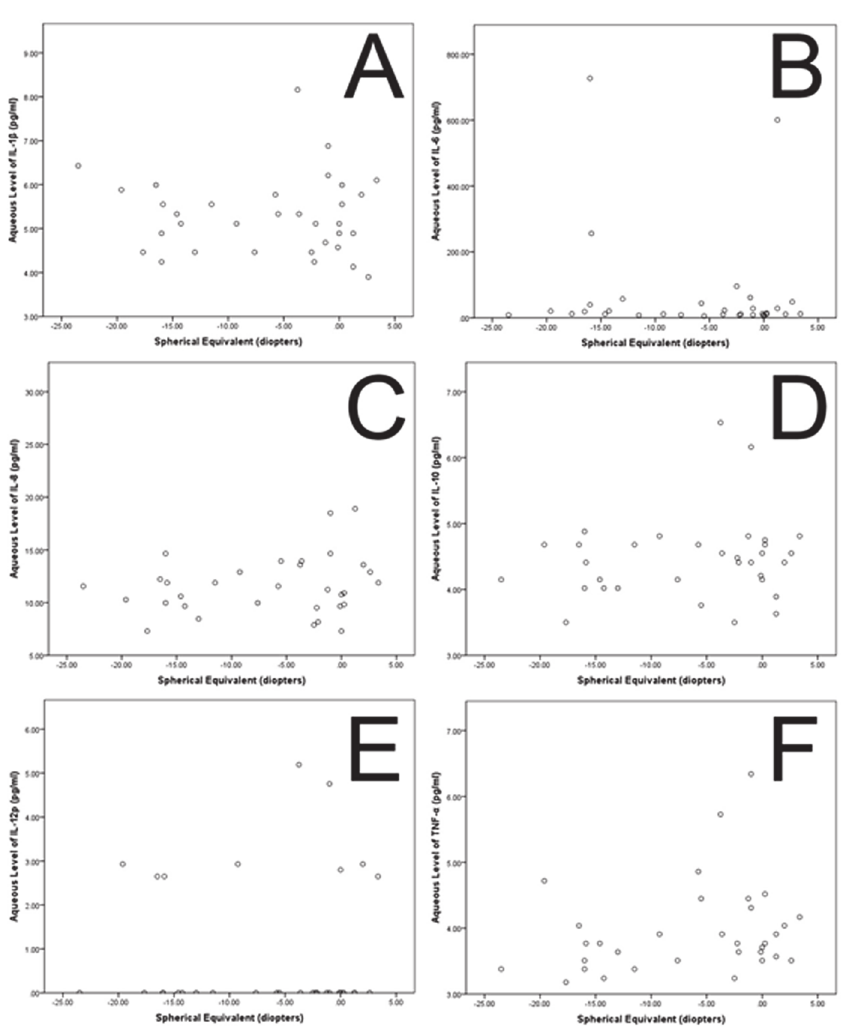
Fig 3. Scattergrams showing the associations between refractive error (spherical equivalent) and the concentrations of interleukin 1 β , 6, 8, 10, 12p (IL-1 β , IL-6, IL-8, IL-10, IL-12p), tumor necrosis factor α (TNF- α ) (A-F) in the aqueous humour of patients without retinal diseases and undergoing routine cataract surgery.